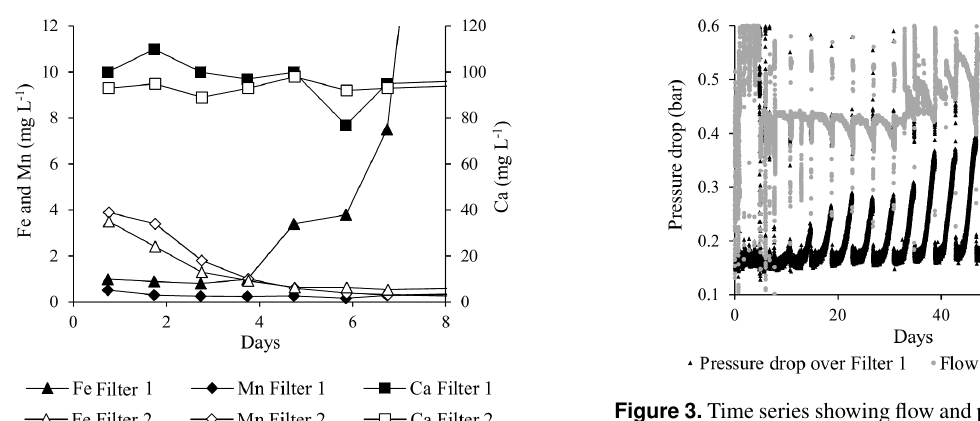
Figure 3. Time series showing flow and pressure drop over Filter